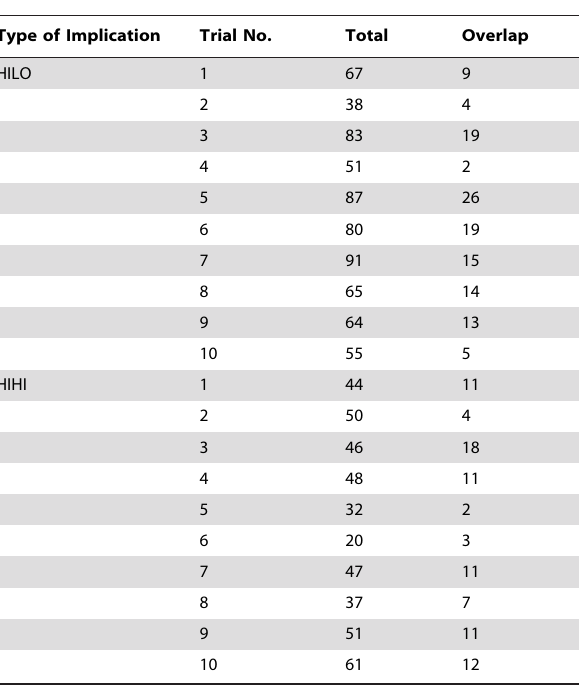
Table 3. Boolean implications versus t test. Table 4. Boolean implications versus